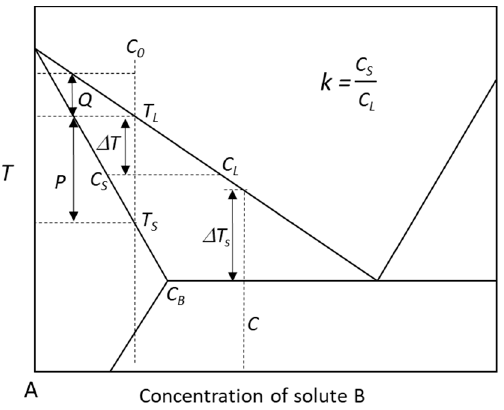
Figure 1. Schematic phase diagram of a binary A-B system showing the definitions of the relevant parameters related to growth restriction, such as P , Q and Δ T s . When C 0 ≤ C B , P = Δ T s ; when C 0 > C B , P > Δ T s , e.g., C 0 = C.